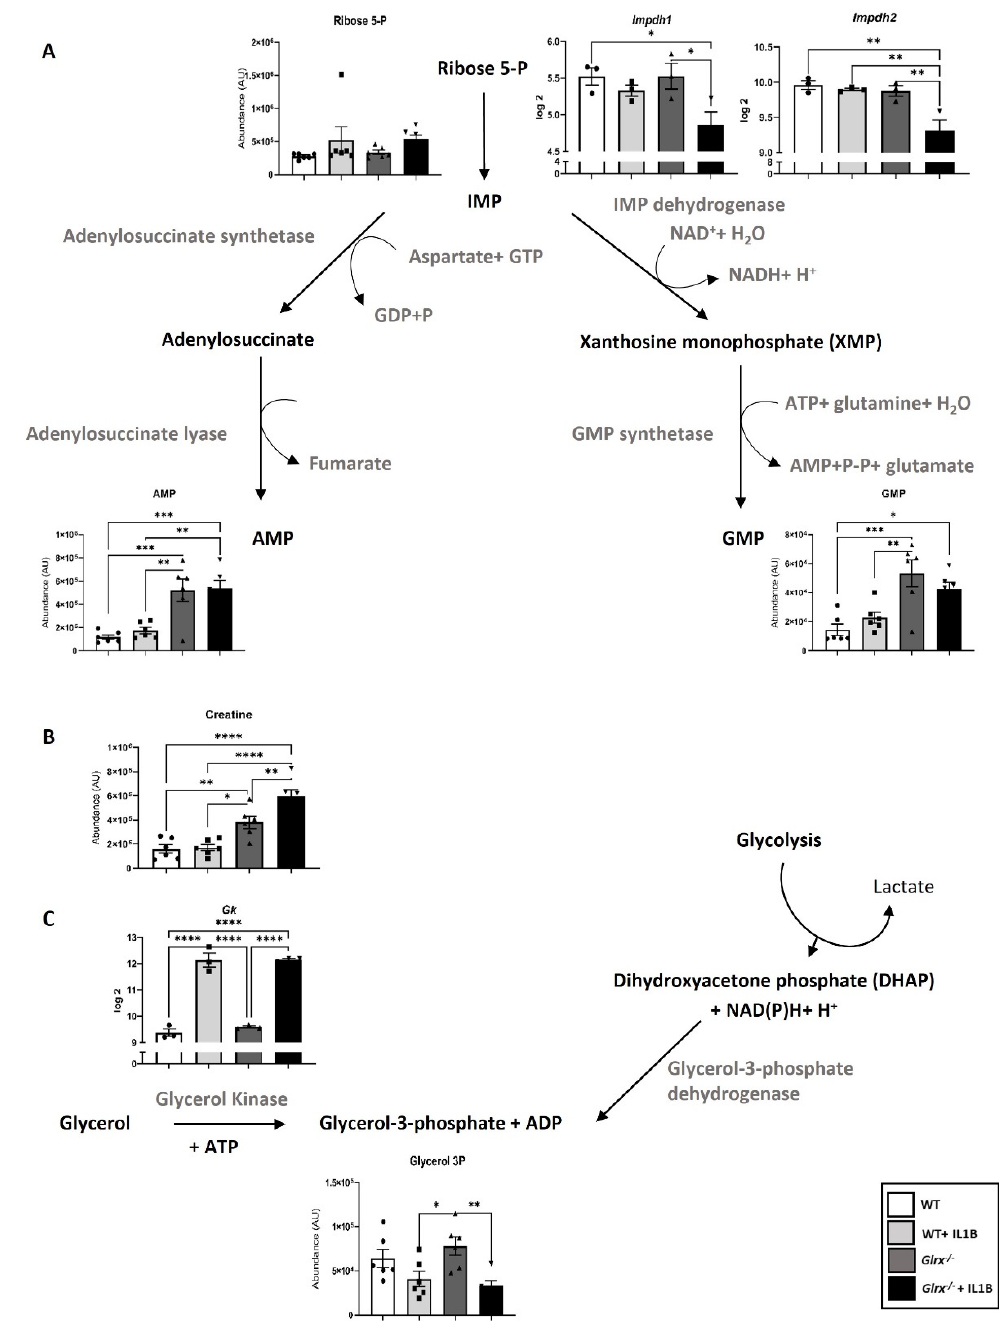
Figure 2. GLRX-dependent modulation of metabolic pathways that regulate AMP, GMP ( A ), creatine ( B ), and glycerol-3-phosphate (C) in airway basal cells stimulated with IL1B. WT or Glrx − / − airway basal cells were stimulated with 10 ng/mL of Il1B for 24 h prior to the assessment of gene expression or metabolite analysis in cell lysates. We refer the reader to Aboushousha et al. [17] for technical details about this study. * p < 0.05, ** p < 0.01, *** p < 0.001, **** p < 0.0001, ANOVA.